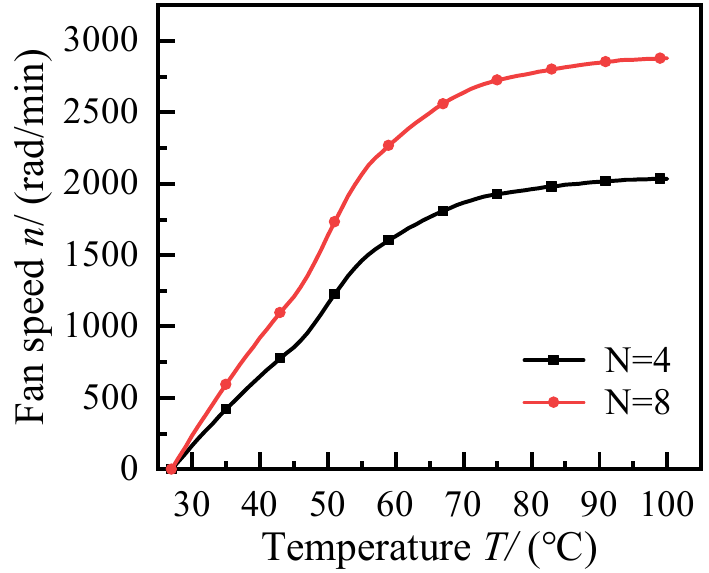
Figure 11. Fan speeds at different temperatures.